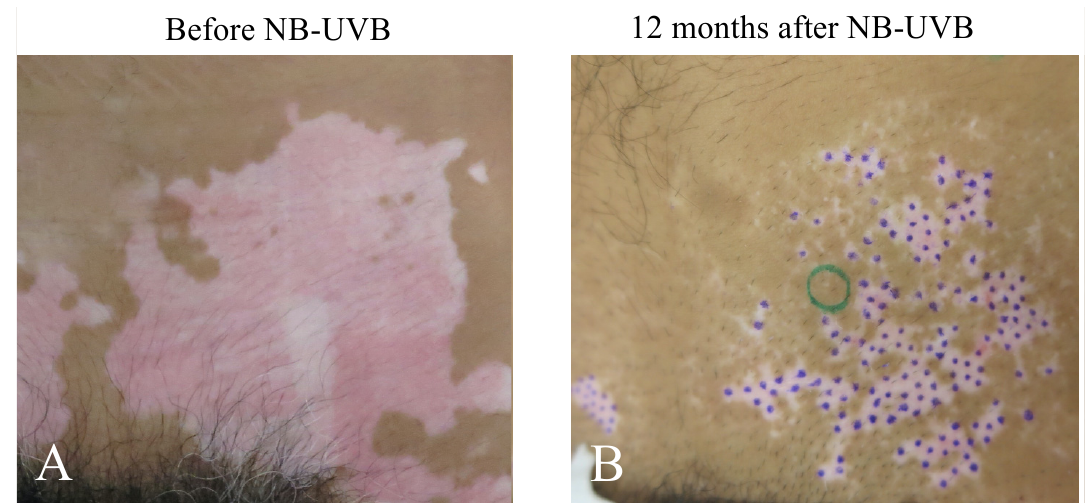
Figure 1. Appearance of lesional skin (lower abdomen, patient No. 1) before ( A ) and after ( B ) expo- sures with NB-UVB. After 12 months, excellent repigmentation was observed. Repigmented areas are present in the patch within the lesional skin (perifollicular repigmentation pattern). Skin biopsy of repigmented area (green circle) was taken ( B ). Small violet dots indicate that the white macules persisted even after the long NB-UVB phototherapy. Green circle shows regimented skin area and 3 skin cites were taken from here for histochemical analysis.